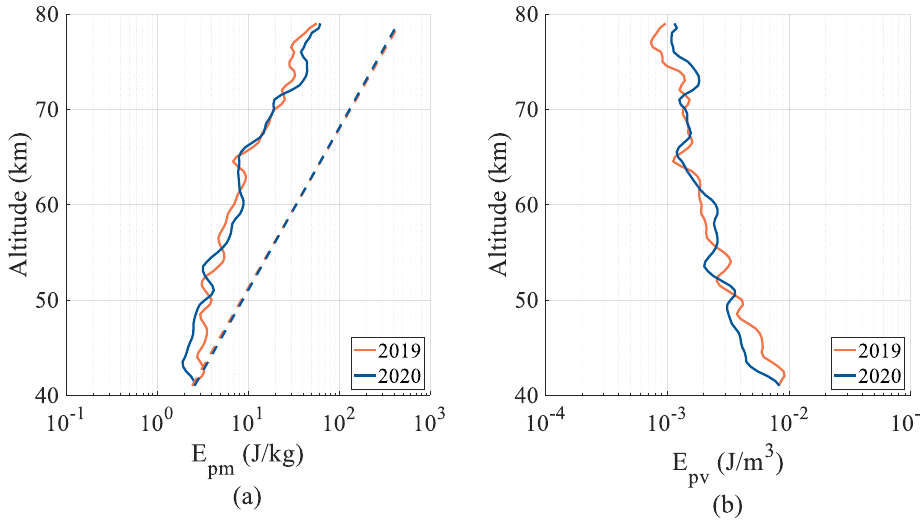
Figure 2. The profiles of GWPED above Jiuquan in 2019 and 2020, including E pm ( a ) and E pv ( b ). The dotted line is the E pm of the energy conservation AGWs.